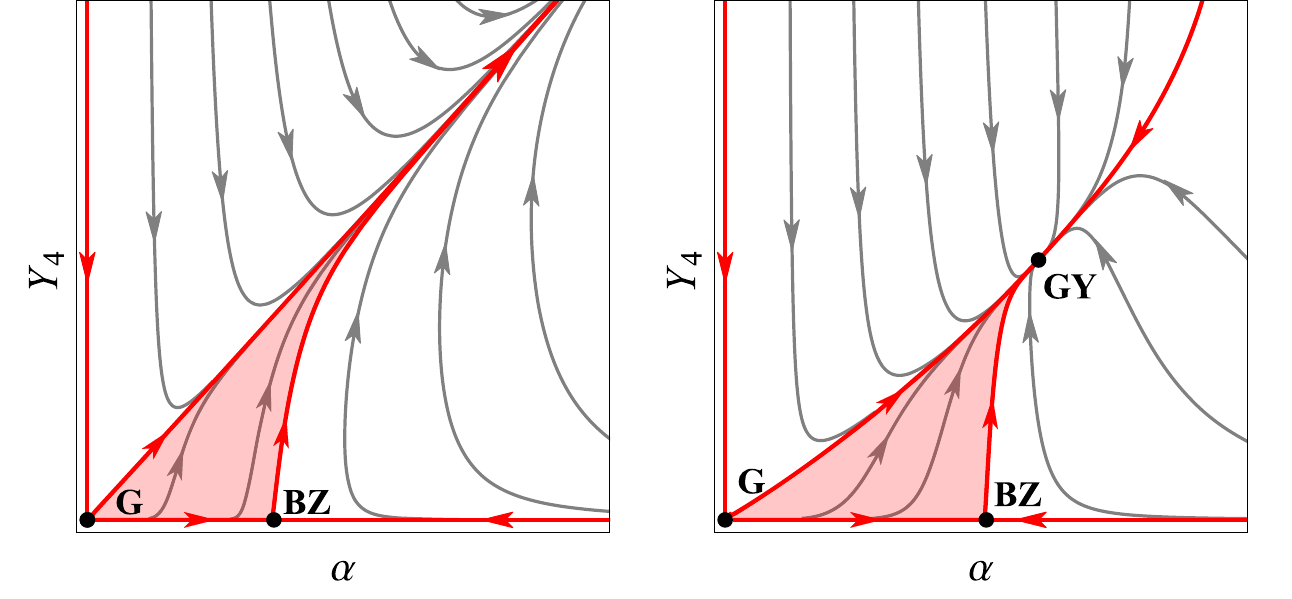
Fig. 3 Phase diagram of gauge–Yukawa theories with B > 0 and C > 0 > C (cid:16) at weak coupling showing asymptotic freedom with the Gaussian and the Banks–Zaks fixed point (BZ). Notice the funneling of all UV free trajectories towards the Yukawa nullcline as furthered by the Banks–Zaks fixed point